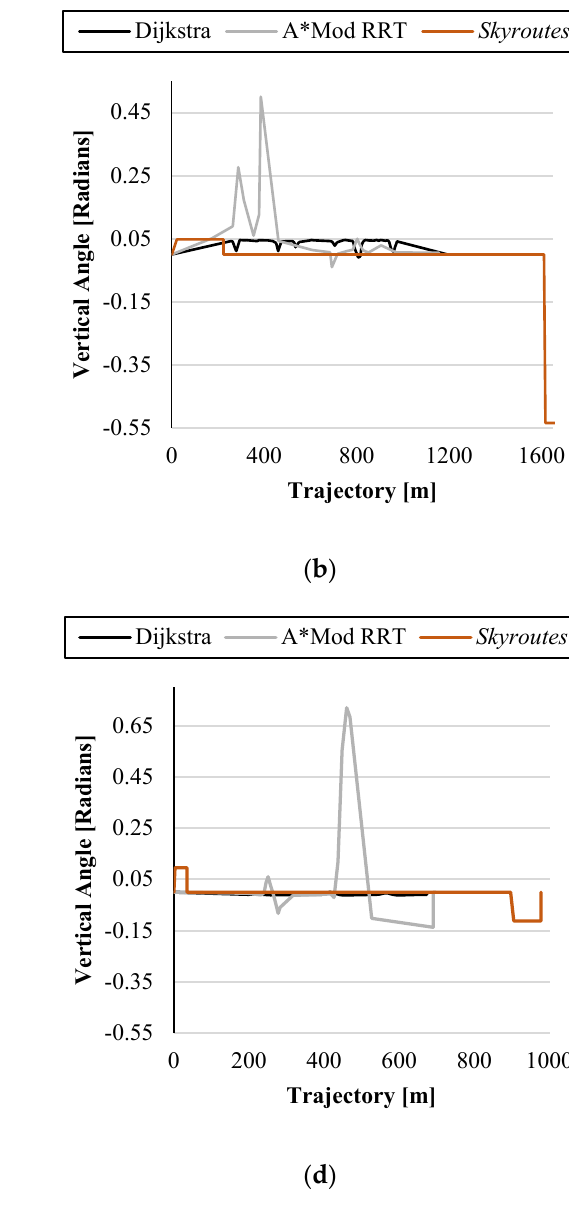
Figure 10. Resolved UAV trajectory variables for scenarios 1 and 2. ( a ) Mission 1 trajectory horizontal angle profile; ( b ) Mission 1 trajectory vertical angle profile; ( c ) Mission 4 trajectory horizontal angle profile; ( d ) Mission 4 trajectory vertical angle profile.